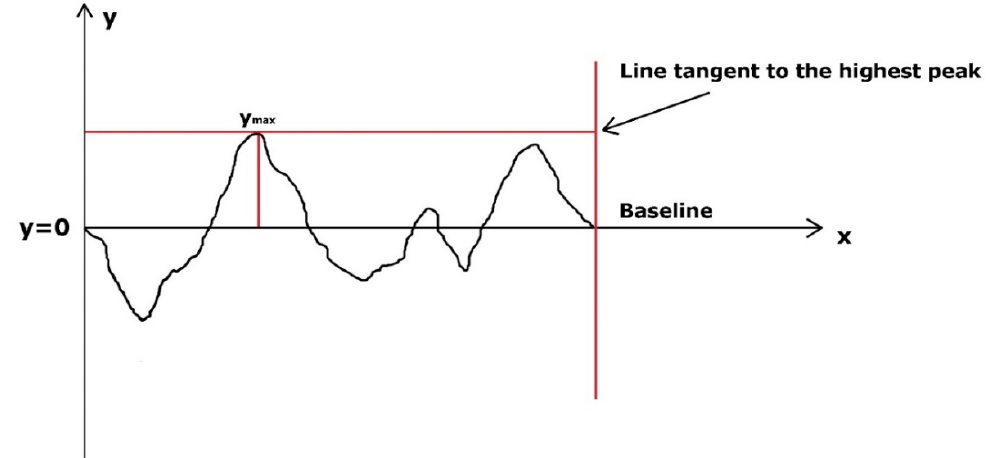
Figure 2. Schematic view of a rough surface.